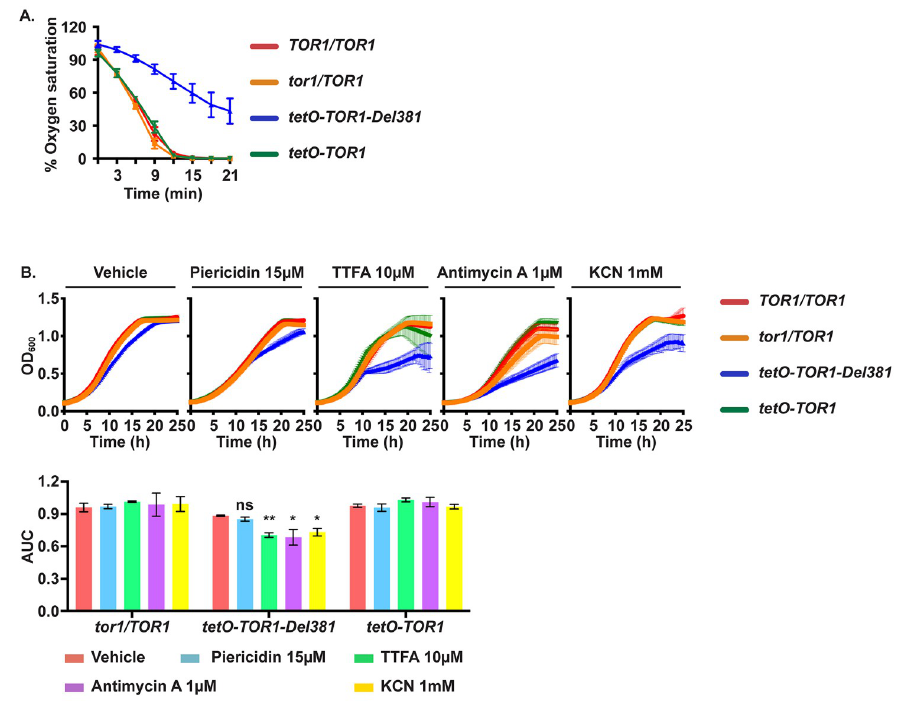
Fig 4. Cells lacking Tor1 N-terminal HEAT repeats were defective in oxygen consumption and hypersensitive to electron transport chain complex inhibitors. A. Percentage of oxygen saturation of the medium in strains with distinct TOR1 alleles grown in YPD. Error bars show SD of 3 biological replicates. ( TOR1/TOR1 ,JKC1713; tor1/TOR1 , JKC1347; tetO-TOR1-Del381 , JKC1441; tetO-TOR1 , JKC1549). B. Cells of indicated genotypes were pre-grown in YPD and inoculated in YNB with 2% glucose without inositol, containing Vehicle (DMSO), Piericidin, Thenoyltrifluoroacetone (TTFA), Antimycin A or potassium cyanide (KCN) at the indicated concentrations. Error bars show SD of 3 technical replicates. ( TOR1/TOR1 ,JKC1713; tor1/TOR1 , JKC1347; tetO-TOR1-Del381 , JKC1441; tetO-TOR1 , JKC1549). The upper panel shows the actual growth curves and the lower panel shows the corresponding area under the curve (AUC) for each condition. ns is p = 0.080 (Piericidin); �� is p = 0.0026 (TTFA); � is p = 0.040 (Antimycin A) and p = 0.016 (KCN); error bars show SD of 3 technical replicates. Representative of 3 biological